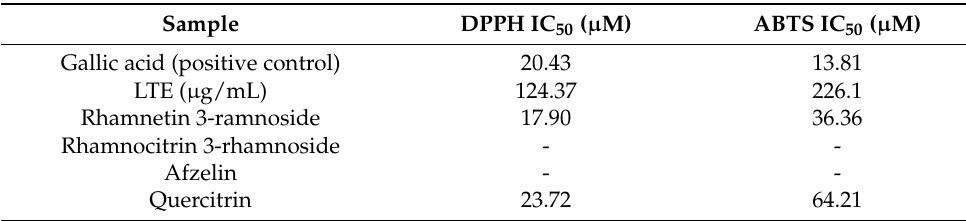
Table 1. IC 50 values in antioxidant assays of LTE and its ingredients.